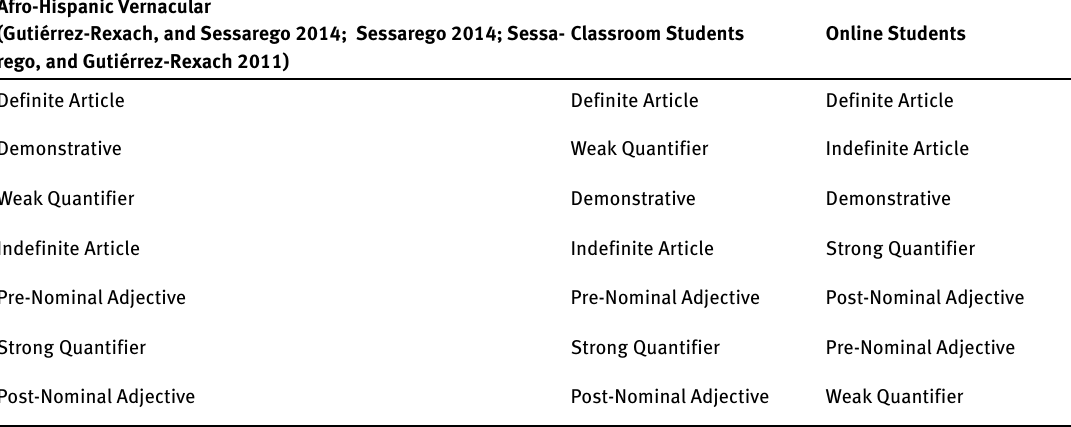
Table 7. Grammatical hierarchy of gender agreement in Afro-Hispanic Vernaculars compared with Beginning Students of Spanish Afro-Hispanic Vernacular (Gutiérrez-Rexach, and Sessarego 2014; Sessarego 2014; Sessa- rego, and Gutiérrez-Rexach